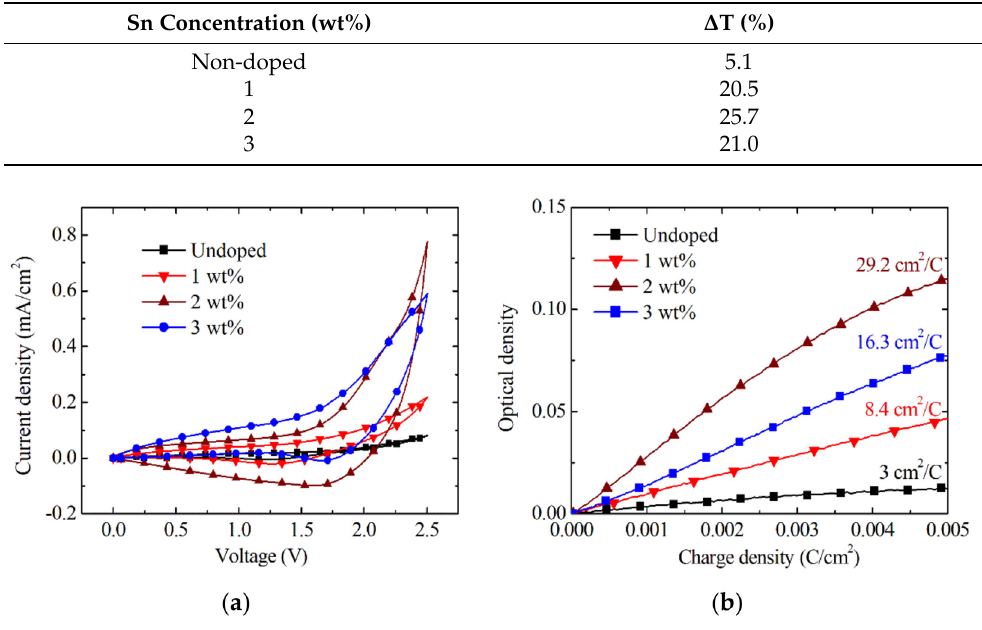
Figure 12. ( a ) Measured cyclic voltammogram performed between 0 V and 2.5 V for differ- ent Sn concentrations and ( b ) optical density versus charge density for the calculation of the coloration